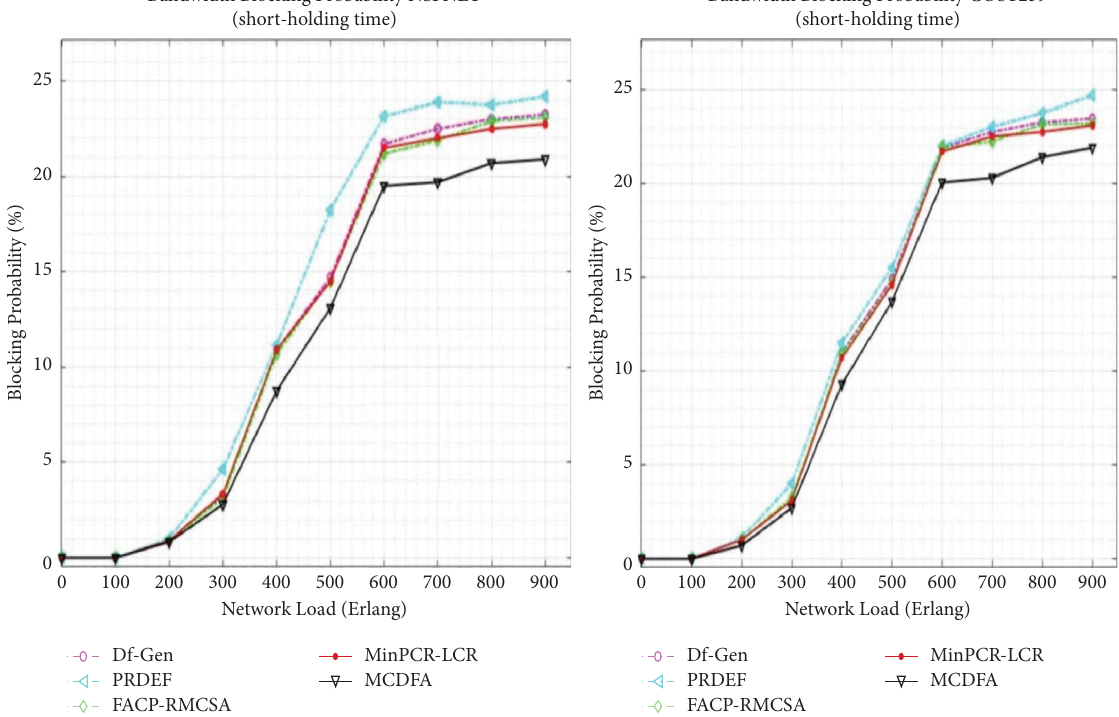
Figure 8: Te blocking probability % for NSFET and COST239 under small holding time arrivals